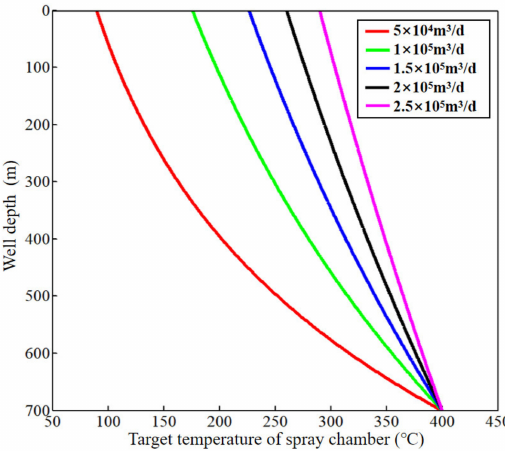
Figure 12. Temperature distribution of produced gas under different outputs.